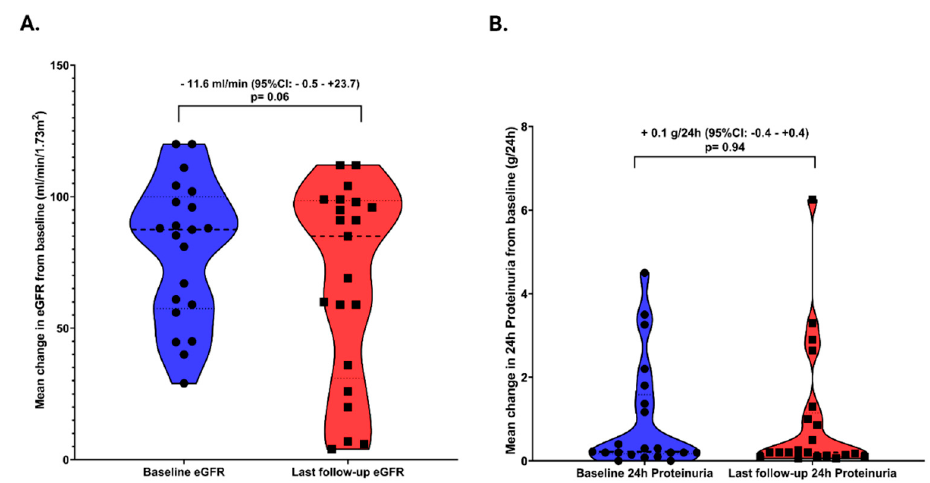
Figure 3. ( A ) Mean change in eGFR; ( B ) 24 h Proteinuria from baseline.